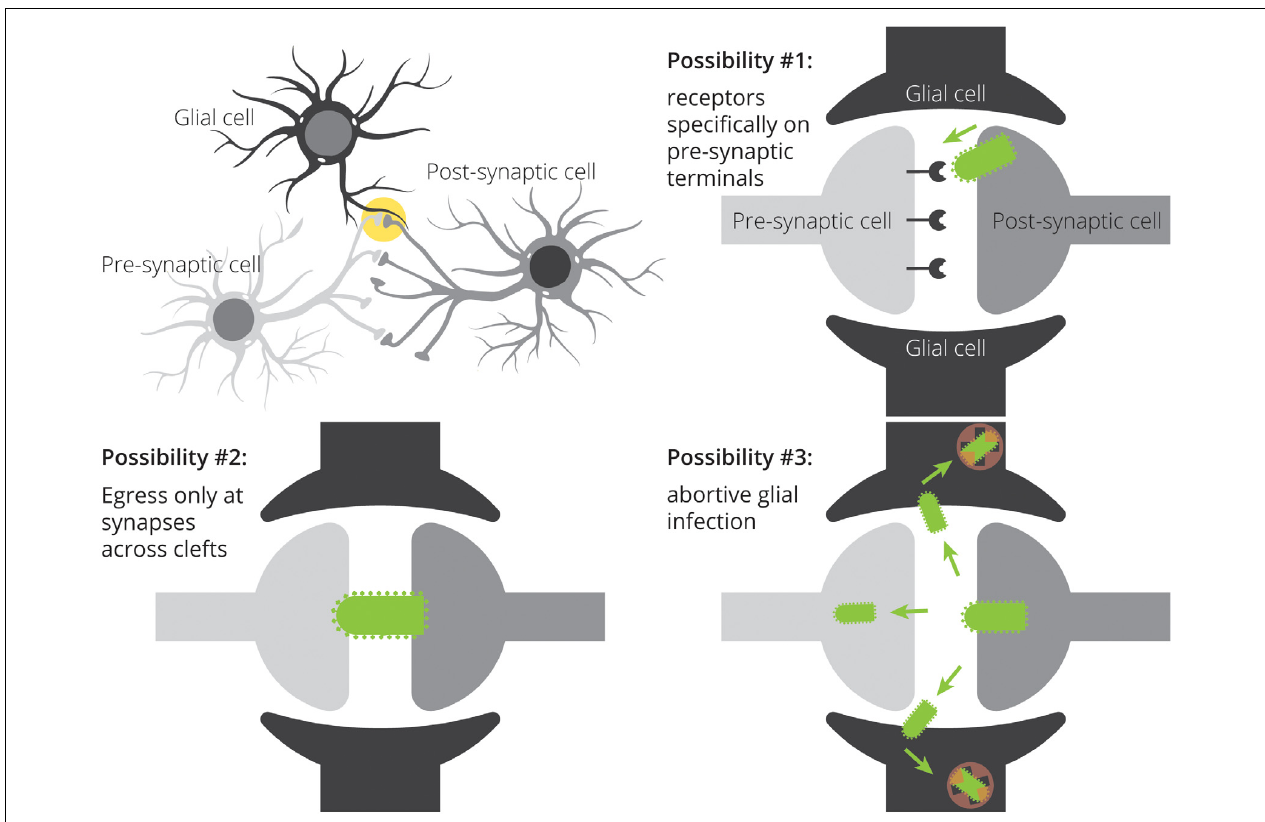
FIGURE 1 | Three potential mechanisms for restricted patterns of RABV spread in the CNS. Spread restricted to preferentially synaptically-connected input cells could be achieved through specific expression of viral receptors on input cell terminals, direct transfer of viruses from post-synaptic cells to pre-synaptic cells without ever needing to bud into the extracellular space, and through non-productive infection of nearby glial cells. A combination of these mechanisms may also influence the apparent labeling